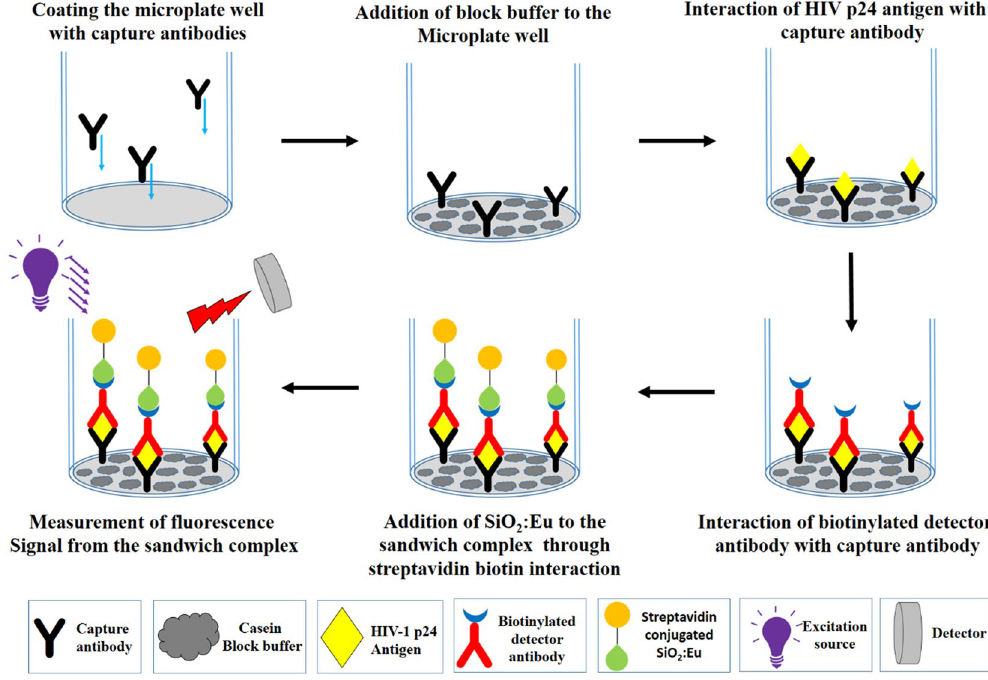
Figure 1. Schematic illustration of SNIA for detection of HIV-1 p24 antigen. HIV-1 p24 is bound to capture antibody which was coated on microtiter wells and then sandwiched with secondary biotinylated anti-p24 antibody. The immunocomplex is then coupled to Streptavidin conjugated silica nanoparticles, which recognizes and binds to the above biotinylated antigen–antibody complex. After extensive washing, the fluorescence signal released from the complex is then recorded and quantified with Spectramax M5 multiplate reader.